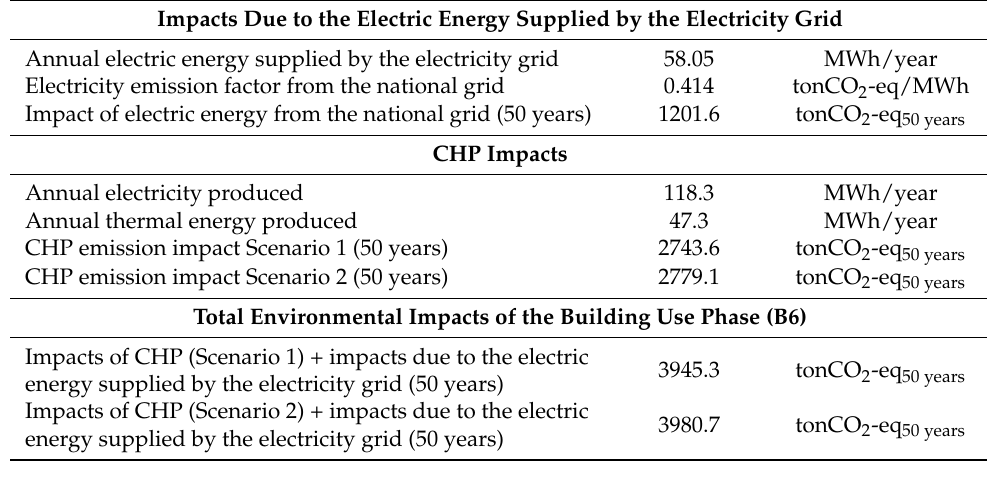
Table 5. Total impact during the project building use phase (B6) for the CNB scenario.